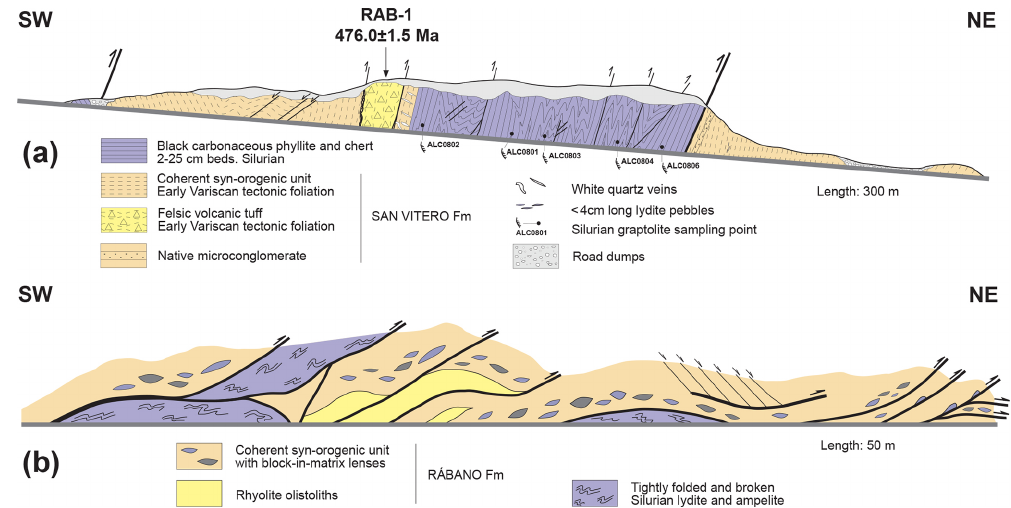
Figure 8. Examples of tectonic mélanges at the base of the synorogenic units in the Alcañices synform. (a) San Vitero duplex slices showing a Lower Ordovician volcanic olistolith above the Silurian fossiliferous sequence. (b) Rábano Formation with rhyolite olistoliths of unknown age and displaying sedimentary block-in-matrix facies lately incorporated to a tectonic